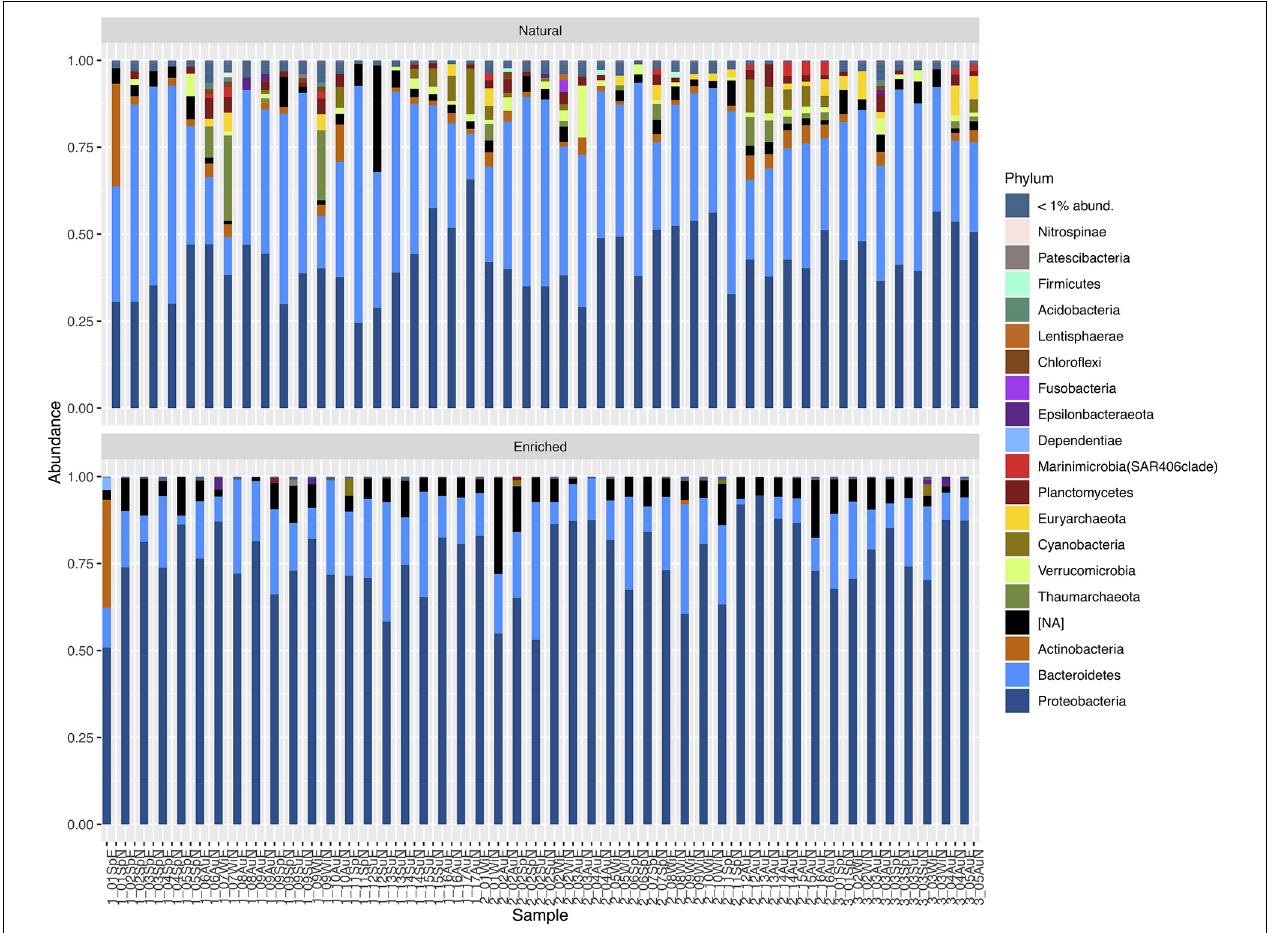
FIGURE 5 | Taxonomic profile of relative abundances of ASVs of natural and enriched microbial communities of 47 sampled sites, at the highest taxonomic level (Phyla with relative abundances below 1% were not considered). NA, Not